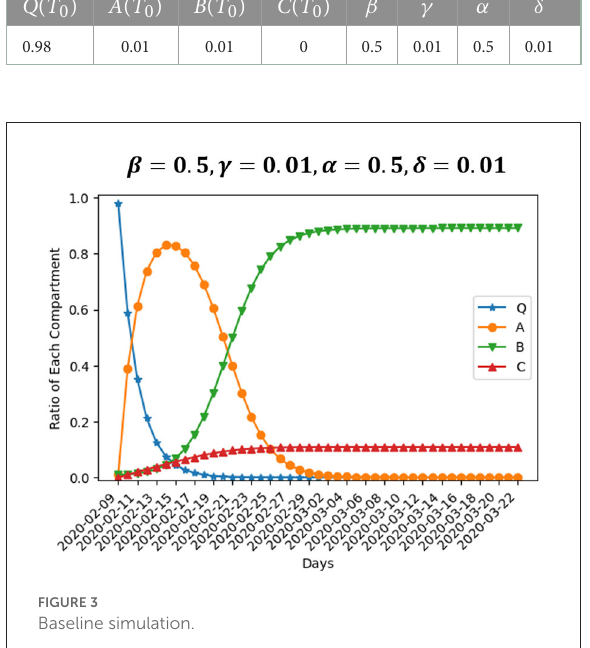
FIGURE3 Baseline